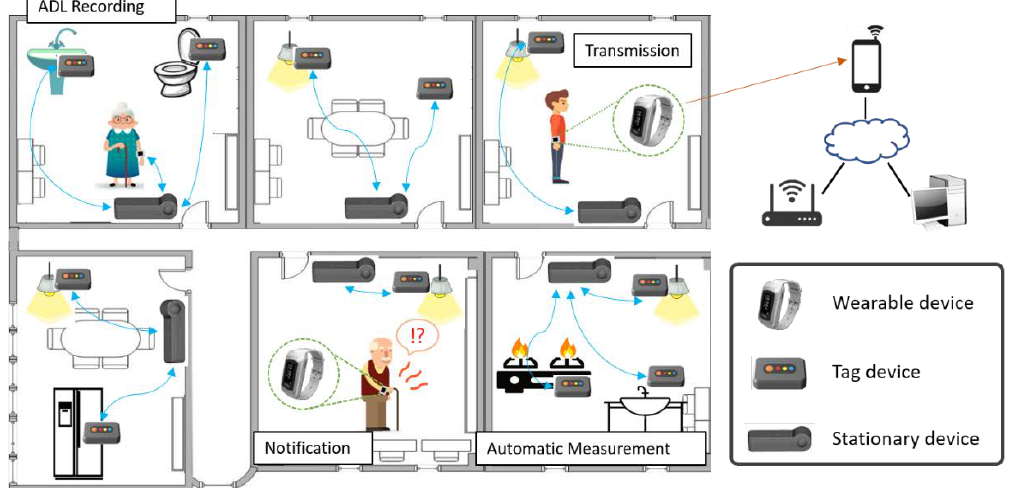
Figure 5. Self-organized activities of daily living (ADL) collection service scenario using three types of portable devices.